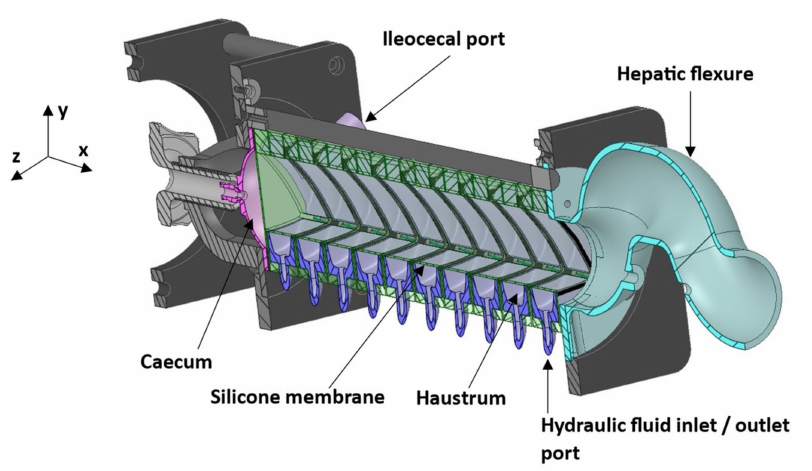
Figure 1. Schematic cross-sectional view of the Dynamic Colon Model (DCM). The DCM has a segmented appearance reflecting that of the human ascending colon: segment 1 is adjacent to the caecum , through to segment 10 adjacent to the hepatic flexure